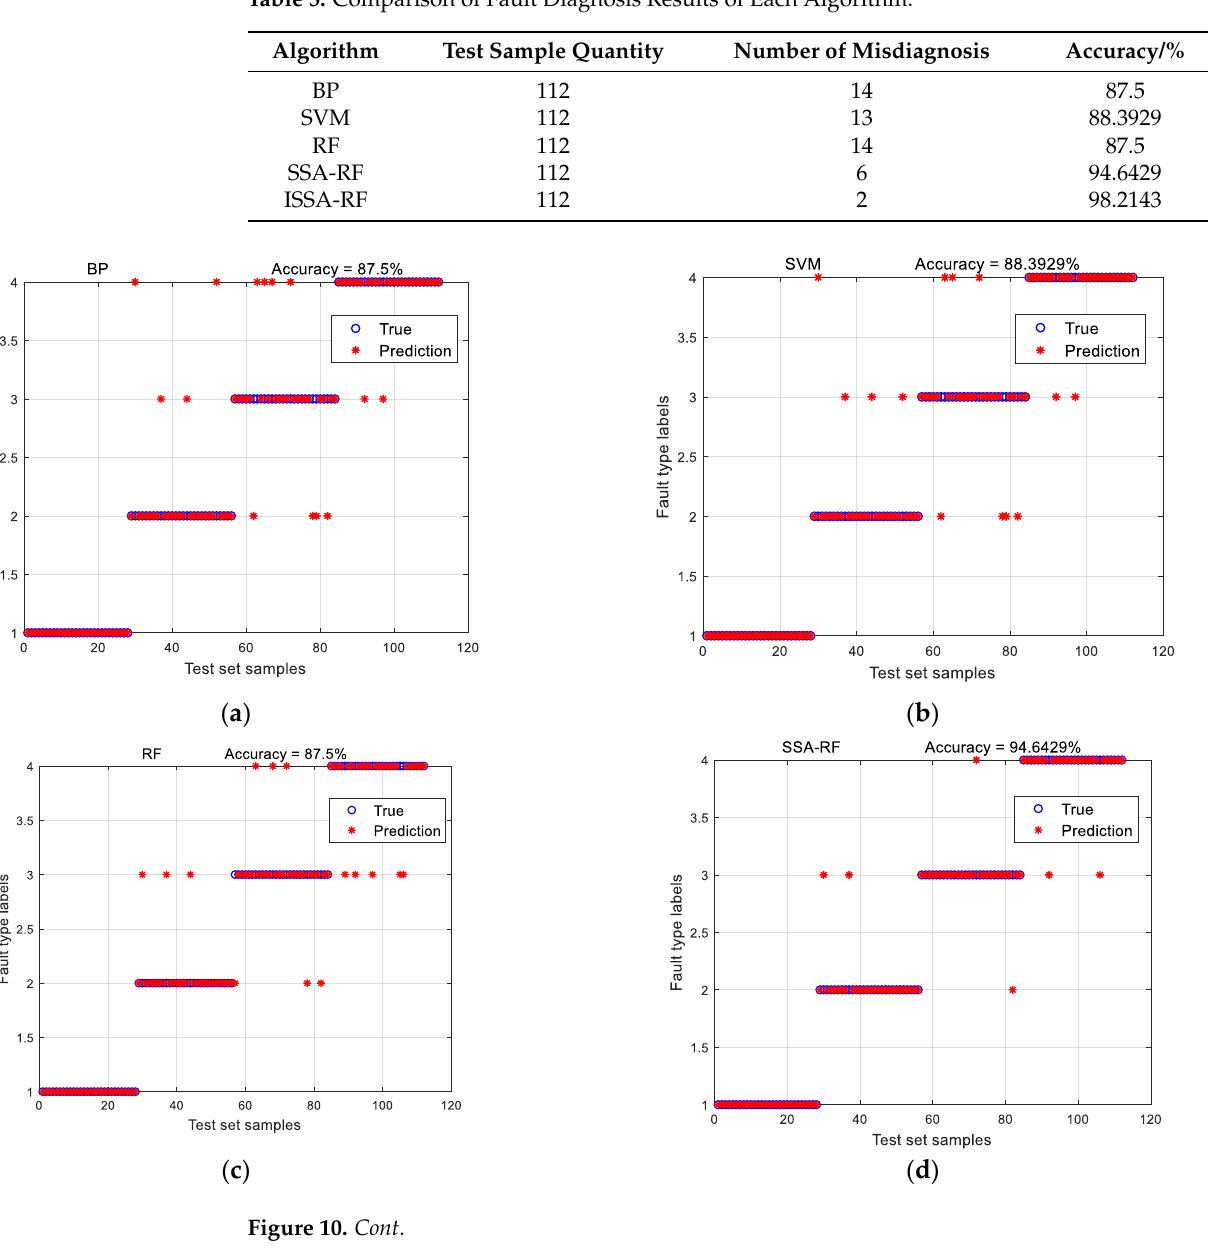
Figure 9. Building a Dataset Flowchart. Table 4. Experimental data sheet.